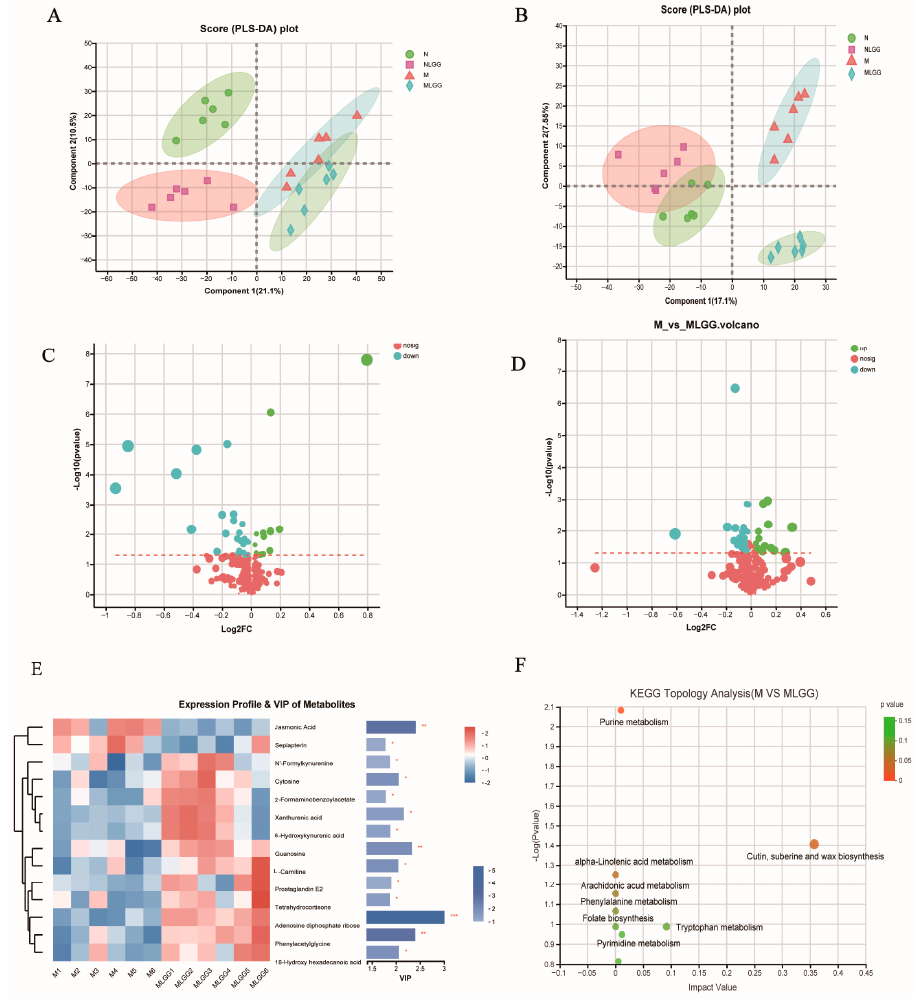
Figure 7. Feces nontarget metabolome analysis in the control group (N group), control group supplemented with Lactobacillus rhamnosus R0011 ( L. rhamnosus R0011) (NLGG group), liver cirrhosis group (M group), and liver cirrhosis group supplemented with L. rhamnosus R0011 (MLGG group). ( A , B ) PLS-DA score plots under the negative and positive ion modes. ( C , D ) Volcano plots of the M and MLGG groups under the negative and positive ion modes. ( E ) Heatmap showing a significant difference in metabolites between M and MLGG (VIP > 1.0, and p < 0.05). ( F ) Metabolic pathways between the M and MLGG groups in the KEGG online database ( n = 6) (* p < 0.05, ** p < 0.01, *** p <